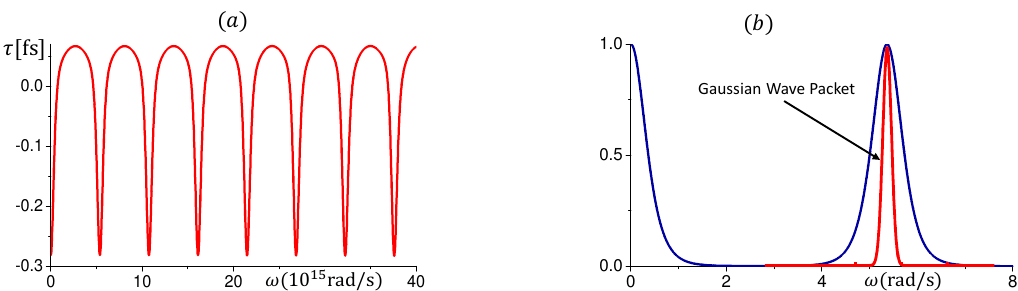
Figure 10. In Panel ( a ), the tunneling (phase) time through the superlattice air ( LR ) 7 air , whose transmission coefficient is shown in the lower panel of Figure 9. The tunneling time through the SL, obtained from τ = ∂ t aSa / ∂ω , at the resonant frequencies is ∼ = − 0.284 fs. In ( b ), a Gaussian wave packet with the centroid at ω (cid:39) 5.32 × 10 15 rad/s, is prepared at t = 0 at a distance z 0 = 10 l c from the SL.